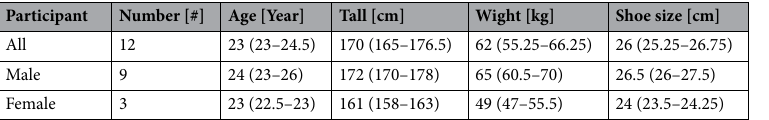
Table 1. The characteristics of the experimental participants including the number, the age, the tall, the weigh, and the shoe size in the median (1st quartile–3rd quartile),